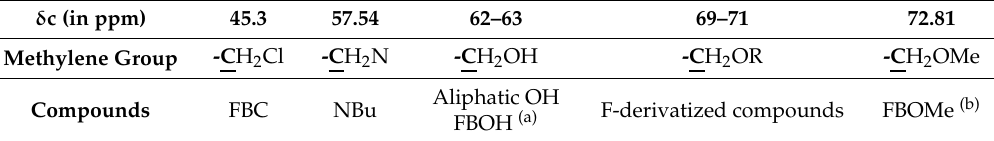
Table 1. 13 C-NMR chemical shifts of -CH 2 (cid:48) groups of derivatives presented in Figure 4 in di ff erent environments.